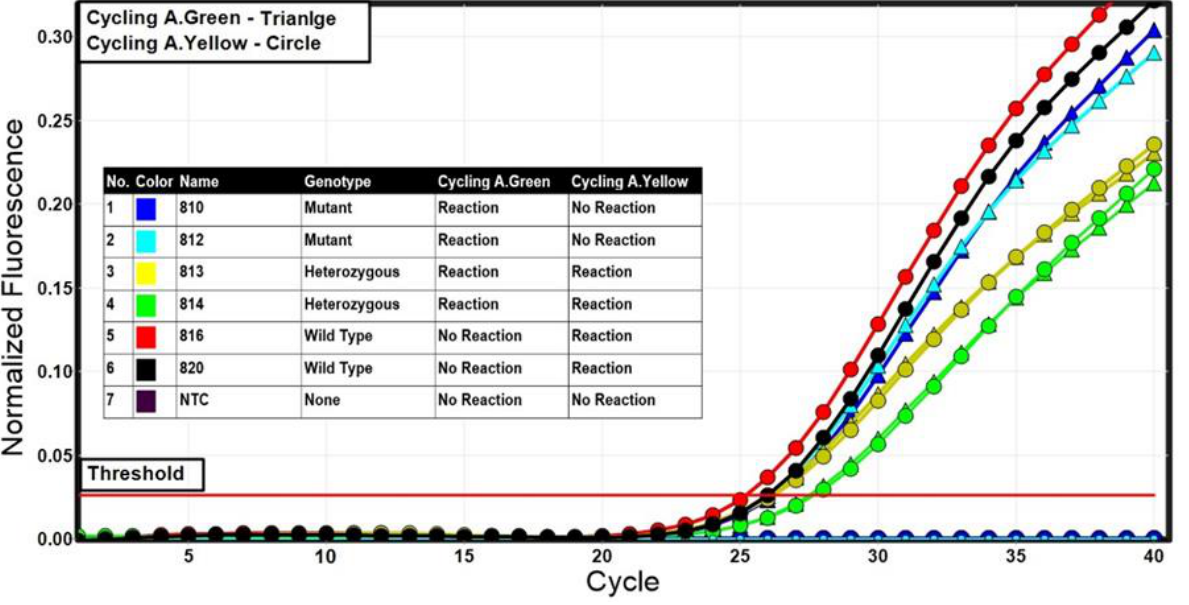
Figure 2. Representative results of the allelic discrimination analysis using the multiplex TaqMan assay. Cycling in the green channel (FAM — A1 mutant allele) was characterized by a curve with triangle while cycling in the yellow channel (HEX — A2 wild-type allele) was characterized by a curve with circle.